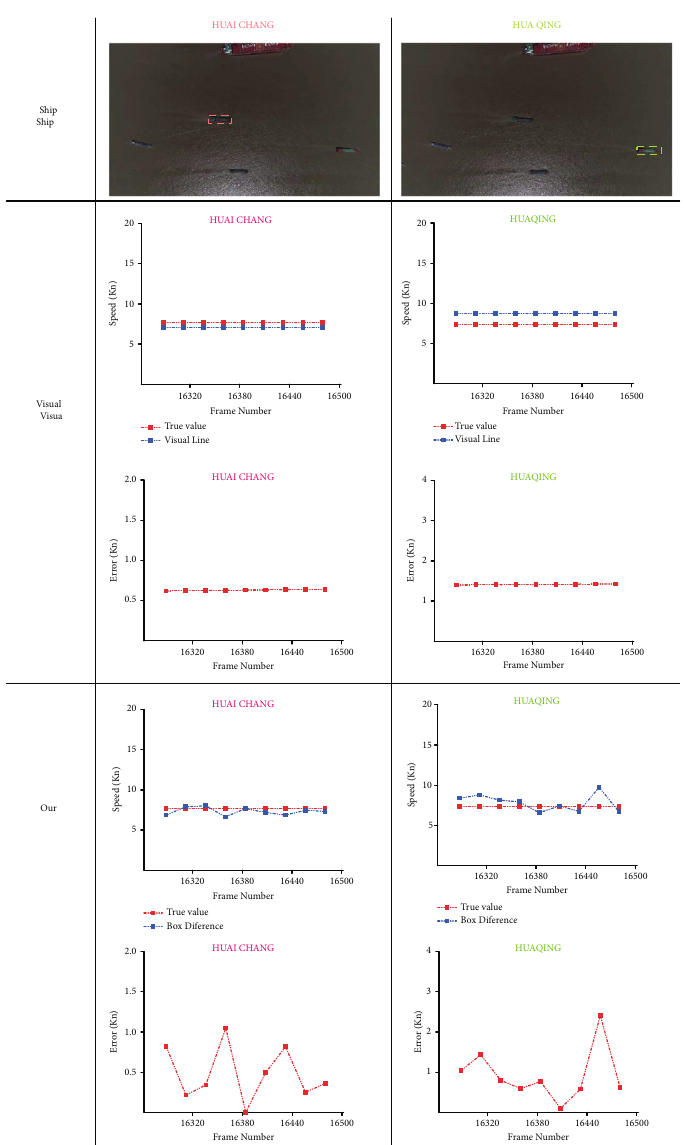
Figure 10: Multimethod of ship speed measurement comparison results. Table 2: Evaluation results of multimethod of velocimetry. Evaluation